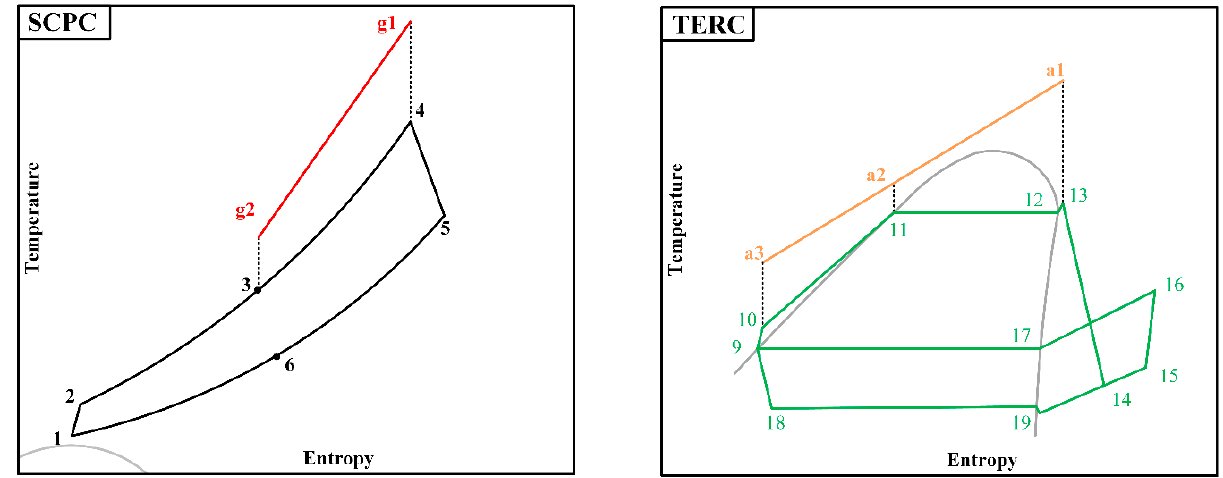
Figure 3. The temperature–entropy figure of the two thermally driven cycles.